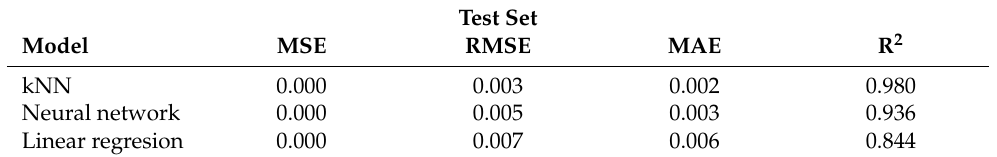
Table 3. Performance results of using the various algorithms to predict the permeability coefficient.